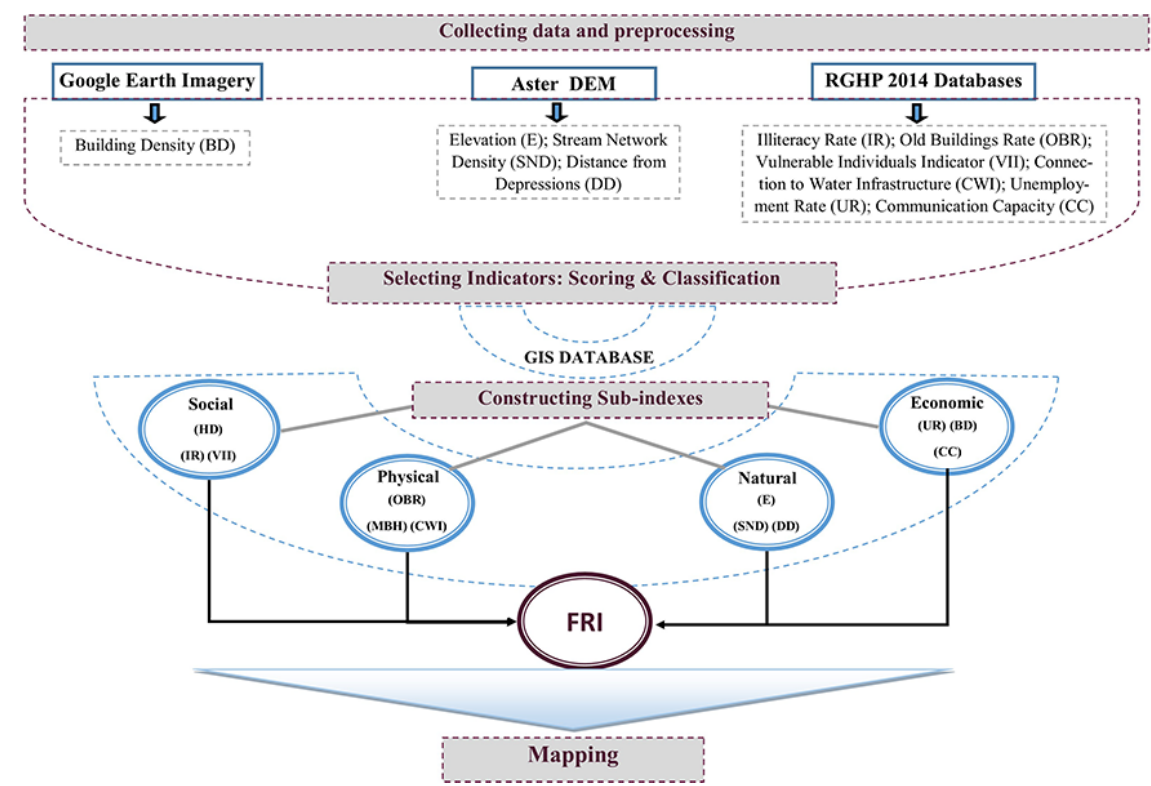
Figure 2. Procedure used to assess flood resilience in the three